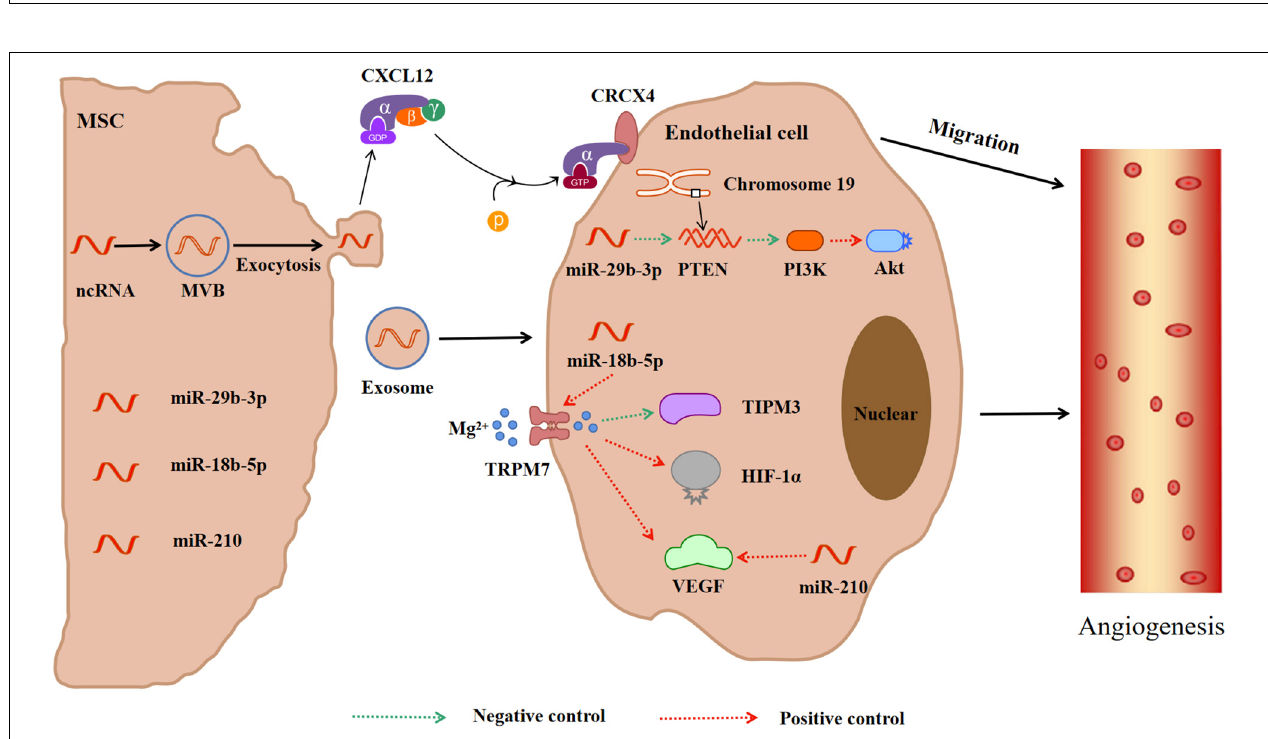
FIGURE 4 | MiRNAs in exosomes secreted by mesenchymal stem cells promote angiogenesis in ischemic tissue. Meanwhile, CXCL12 secreted by exosomes can bind to CRCX4 and promote the migration of cerebrovascular endothelial cells to ischemic tissue. In addition, miRNAs in exosomes activate PTEN-PIK3-Akt or TRPM7-TIPM3/HIF-1 α /VEGF pathways to promote angiogenesis. CXCL12 = SDF-1, Stromal cell derived factor 1; CRCX4, CXC receptor type 4; PTEN, Phosphatase and tensin homolog; PIK3, Phosphatidylinositol 3-kinase; Akt, Protein kinase B; TRPM7, Mg 2 + transmembrane transport channel; TIPM3, Tissue inhibitor of metalloproteinase 3; HIF-1 α , Hypoxia induce factor-1 α ; VEGF, Vascular endothelial growth factor.